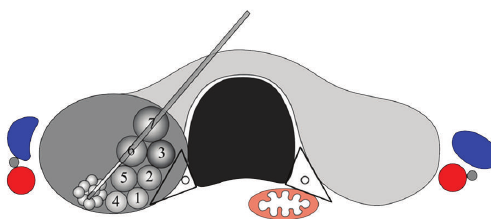
Figure 1: Schema of the transisthmic approach and the moving shot technique. The needle is inserted through the isthmus in order to visualize the entire length of the electrode and the target nodule. Ablation starts from the deepest portion of the nodule to the superficial area according to the order of the numbering of each small conceptual ablation unit, by moving the electrode tip. The ablation area is small near the peripheral danger triangle (black triangle), while it is large in the central, safe area. Recurrent laryngeal nerve (black circle) is within the danger triangle. The carotid artery (red color), internal jugular vein (blue color), and vagus nerve (gray color) are lateral to each thyroid